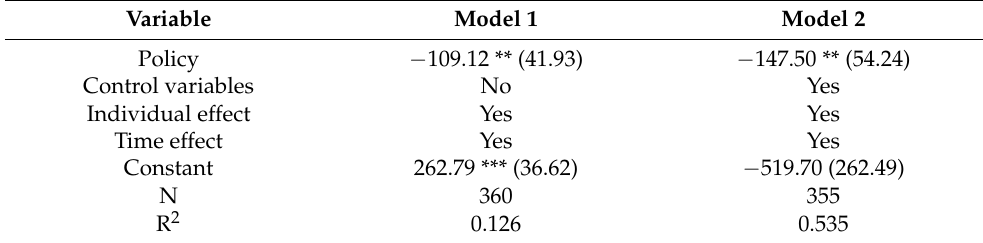
Table 3. Effect test of the carbon trading mechanism pilot.